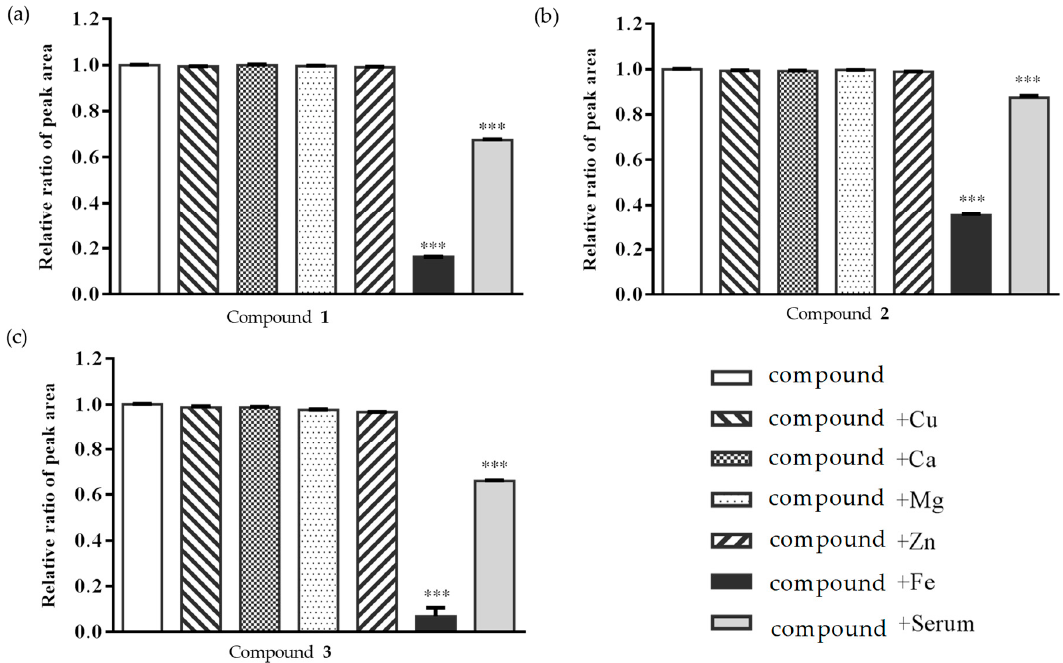
Figure 5. Metal chelating activity analysis. Measure of chelation activity retained in plasma for the phenylethanoid glycosides, ( a ) compound 1 , ( b ) compound 2 and ( c ) compound 3 in the presence of copper (Cu), calcium (Ca), magnesium (Mg), zinc (Zn), iron (Fe), or rat serum by UPLC analysis. The data represented mean ± S.D., n = 3. *** p < 0.001 compared with compound